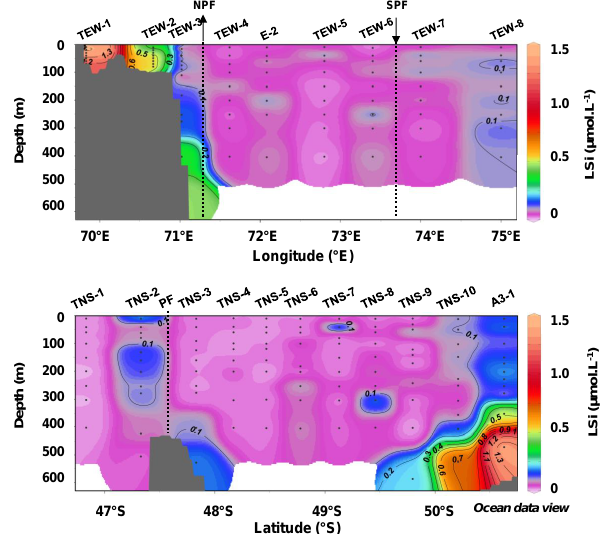
Figure 14. Figure 14. Vertical distribution of lithogenic silica (LSi) concentra- tions along the TEW and TNS transects. The dotted lines represent the approximate location of the southern branch of the polar front going to the north (NPF) and to the south